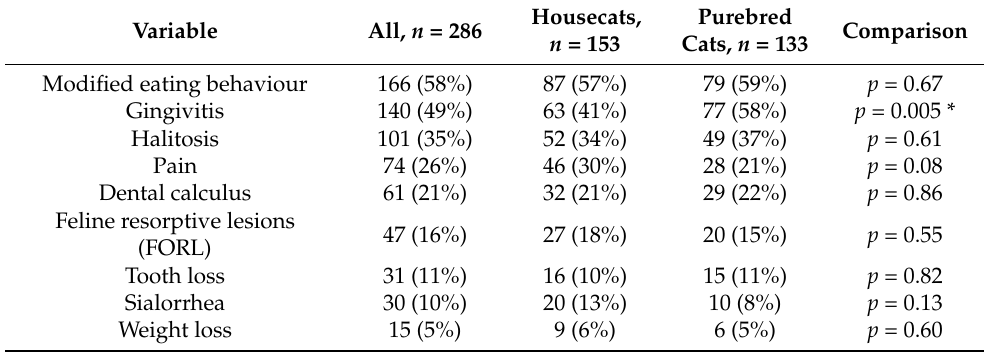
Table 2. Information on cat owners’ knowledge on signs for dental problems, from a survey to